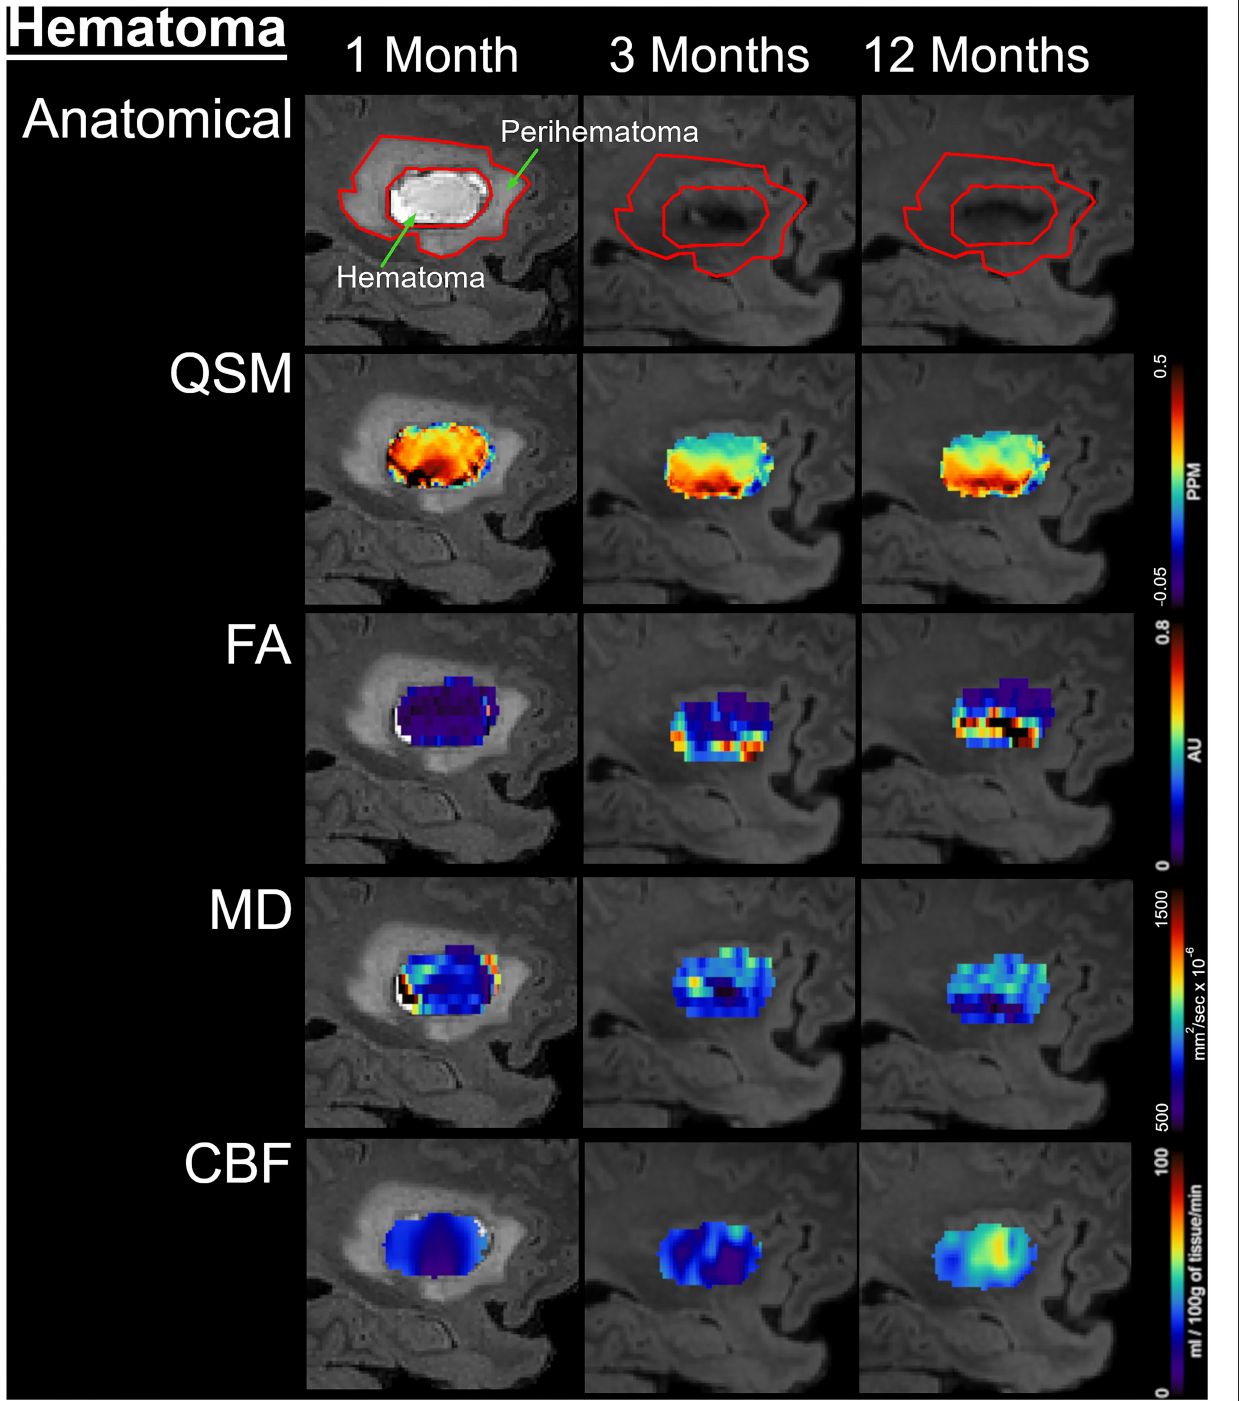
FIGURE 2 | Temporal changes in the hematomal tissues are shown on a fluid-attenuated inversion recovery (FLAIR) by color-coded voxel by voxel quantitative maps in a patient. The rows are illustrating the imaging measurements whereas columns are showing changes at 1, 3, and 12M after onset. In the top row, the first image outlines the perihematomal and hematoma regions that were used as an ROI to measure imaging matrices over time. The other two images on the same row are showing the decrease in hematoma volume with a hypo-intense hemosiderin region at 3 and 12M. The rows 2–5 display QSM maps, FA, MD, and CBF in the hematomal tissues over time,